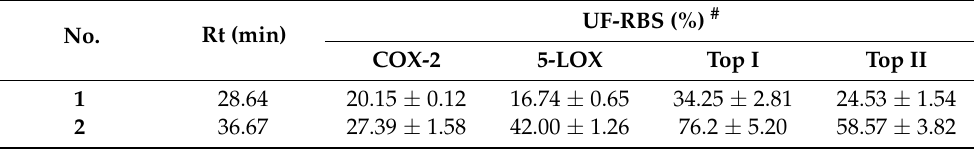
Table 1. The relative binding strength (RBS) values of representative peaks 1 and 2 from W. ugandensis in AUF-HPLC-MS/MS.